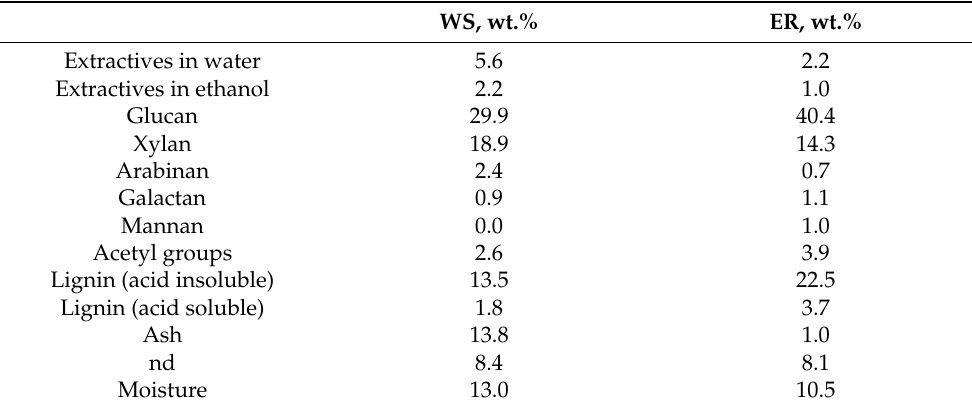
Table 1. Compositions of the starting biomasses: wheat straw (WS) and eucalyptus residue (ER), reported on the dry matter basis. WS, wt.% ER,